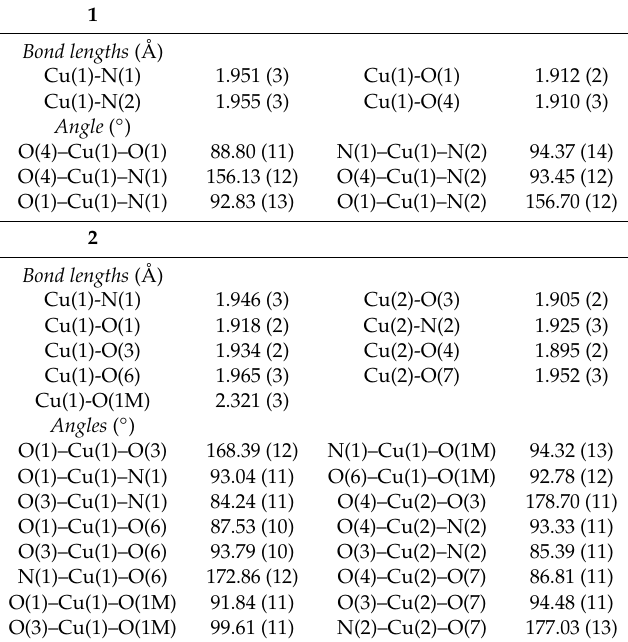
Figure 11. The thermogravimetric (TG), the differential thermal analysis (DTG), and the differential scanning calorimetric (DSC) curves of the thermal decomposition of complex 1 in air.